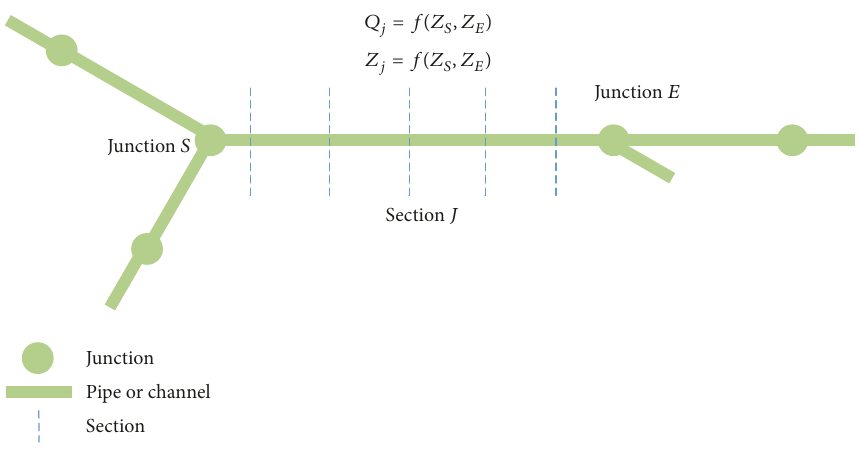
Figure 1: Schematic illustration of pipe network and flow